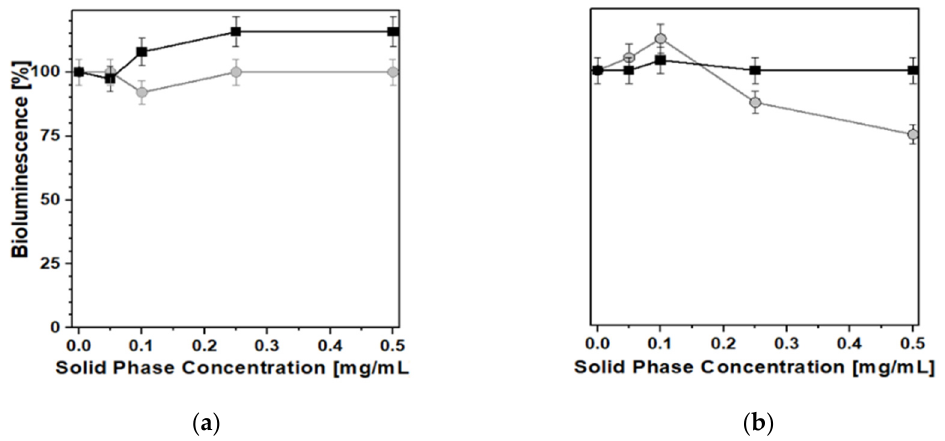
Figure 10. Acute (2 h; a ) and chronic (24h; b ) effects of ● PB_Syn and ■ PB_Com samples on E. coli (pXen7) bioluminescence. T = 37 °C.